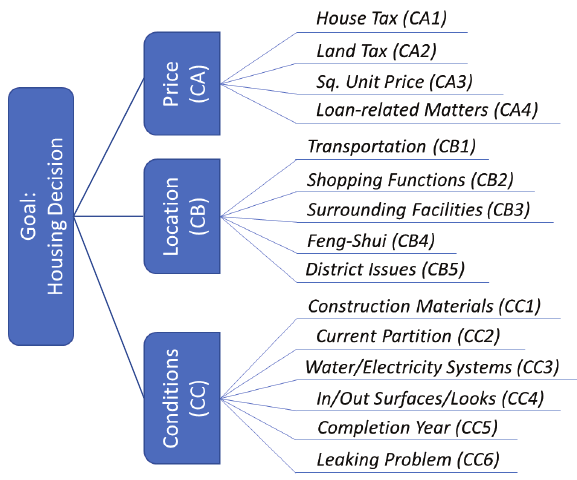
Figure 1. Th e AHP